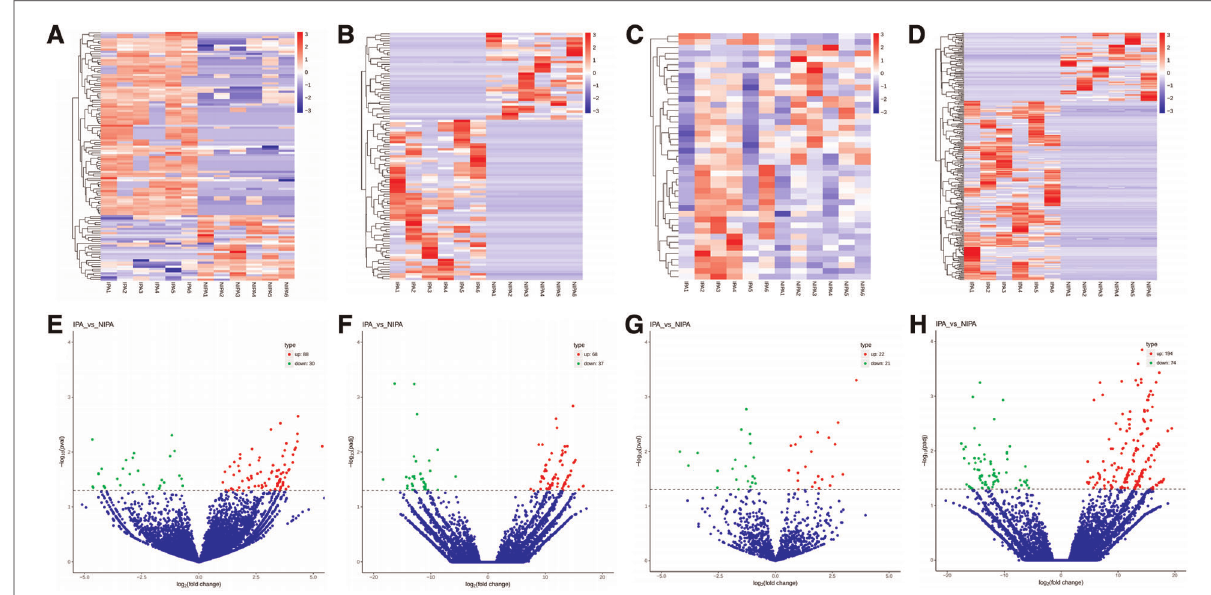
FIGURE 2 ( A – D ) Cluster heat map of DEcircRNAs, DElncRNAs, DEmiRNAs, and DEmRNAs. Red indicates up-regulation and blue indicates down-regulation. ( E – H ) Volcano map of DEcircRNAs, DElncRNAs, DEmiRNAs, and DEmRNAs. Red indicates up-regulation and green indicates down-regulation. DE, differential expression; circRNA, circular RNA; lncRNA, long chain non-coding RNA; IPA, invasive nonfunctional pituitary adenomas; NIPA, non-invasive nonfunctional pituitary